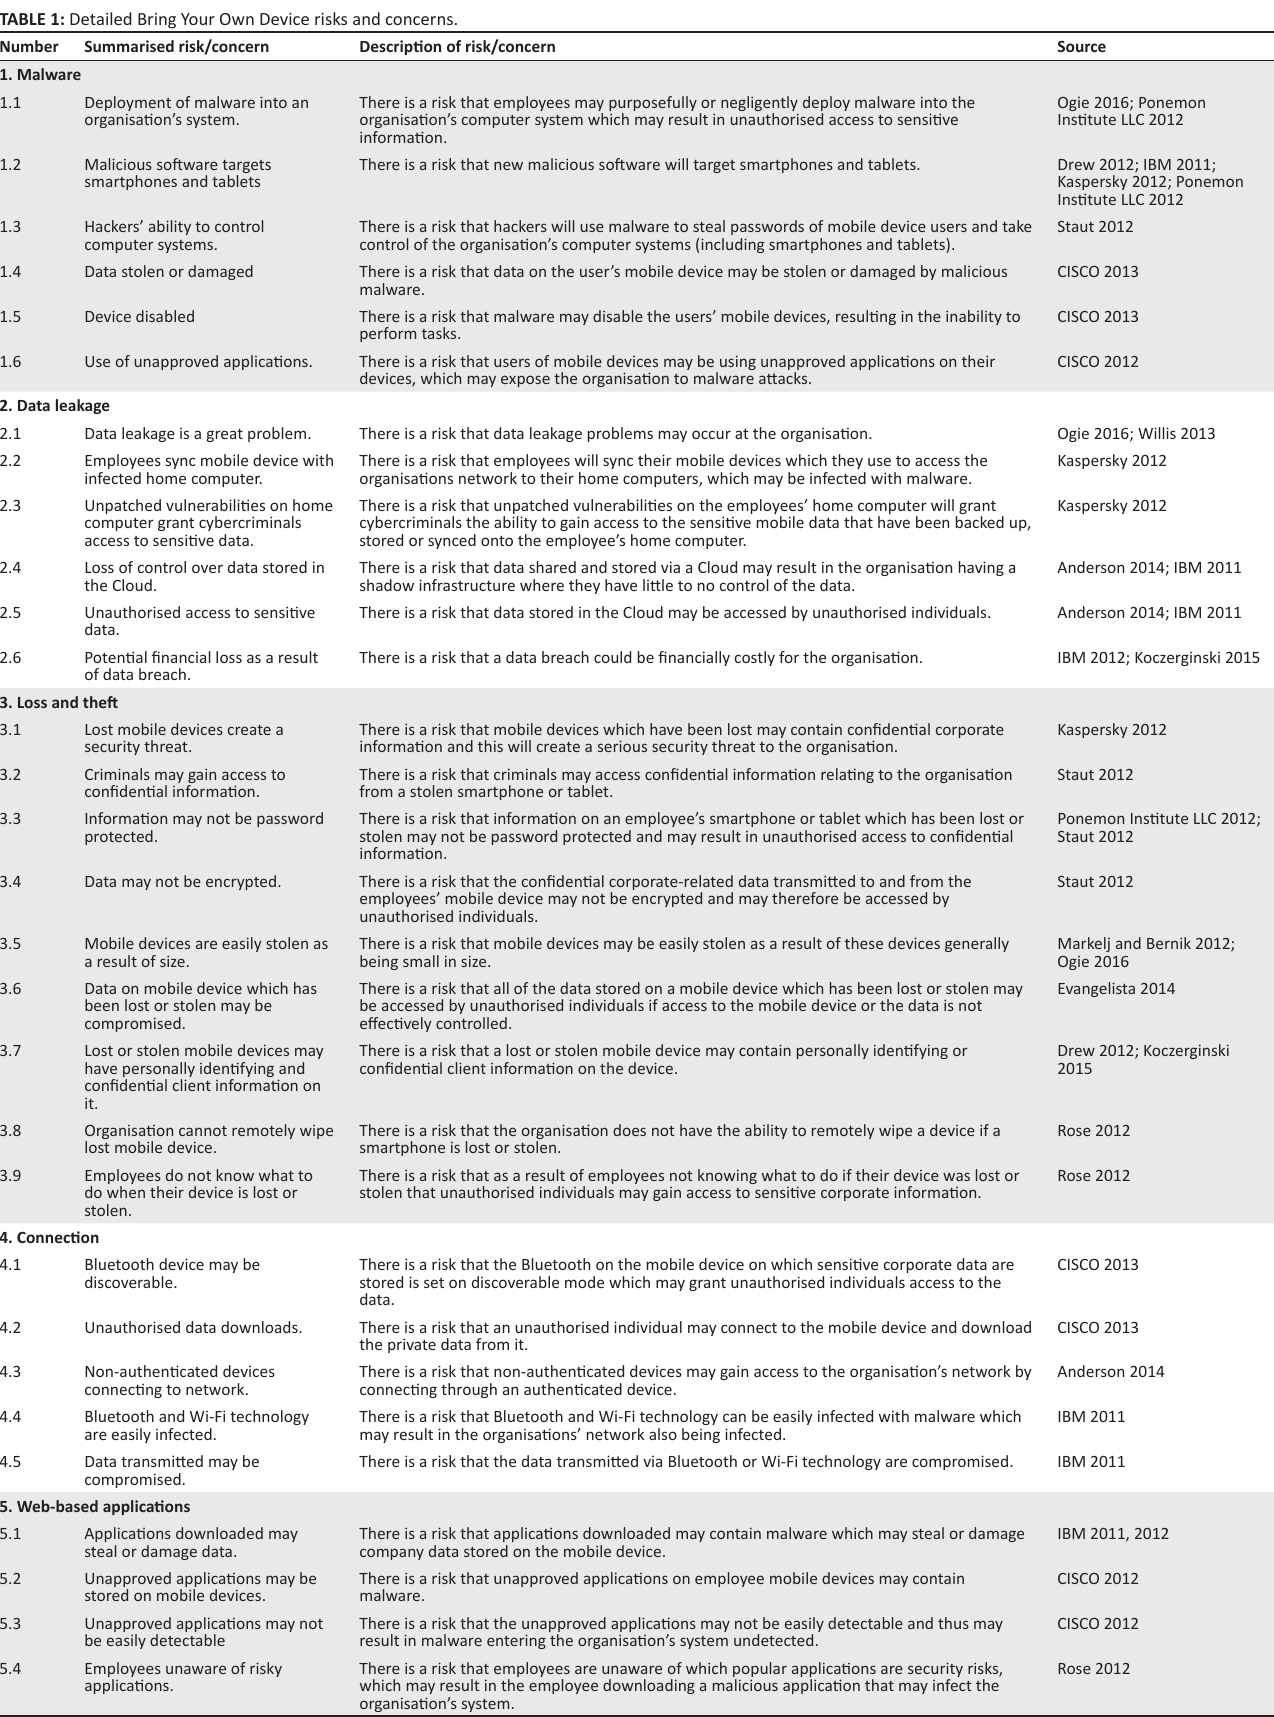
TABLE 1: Detailed Bring Your Own Device risks and